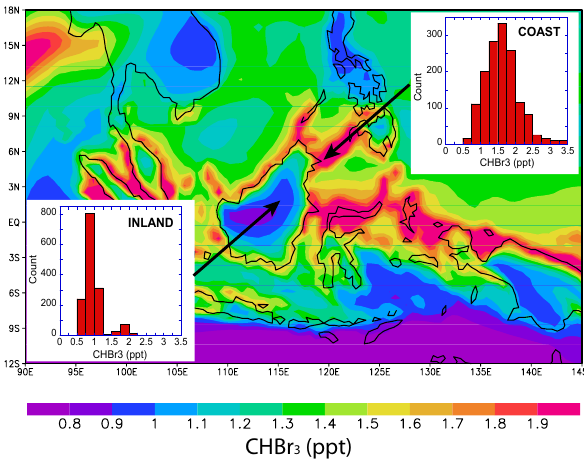
Fig. 10. Surface monthly mean June bromoform mixing ratios mod- elled by p-TOMCAT for the same scenario as in Fig. 9. The insets show the distribution of modelled mixing ratios through the month for an inland and coastal